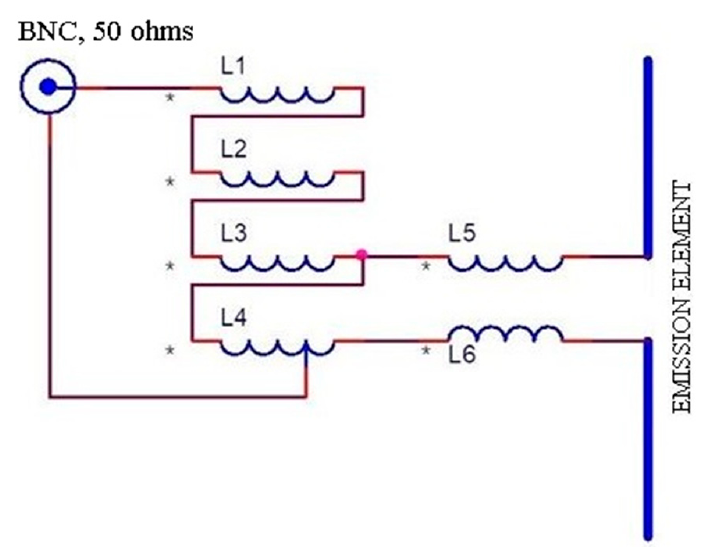
Figure 4. Electrical diagram of the BAL-UN and the symmetrizer (* represents the beginning of the inductor winding). The adapters “in Π ” are used to cancel the imaginary (reactive) part of the emission element impedance. I used the diagram shown in Figure 5.